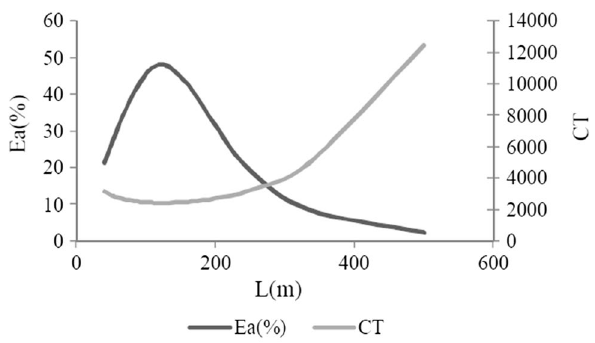
Fig. 2 Sample of cost and irrigation efficiency variations related to length of